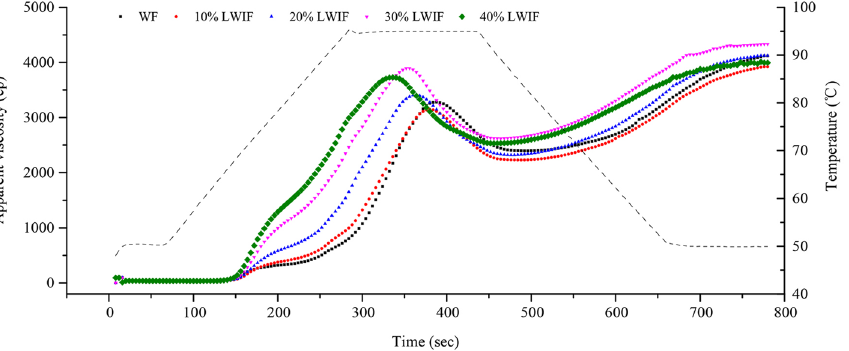
Figure 1. RVA profile of WF and LWIF of different substitution level.